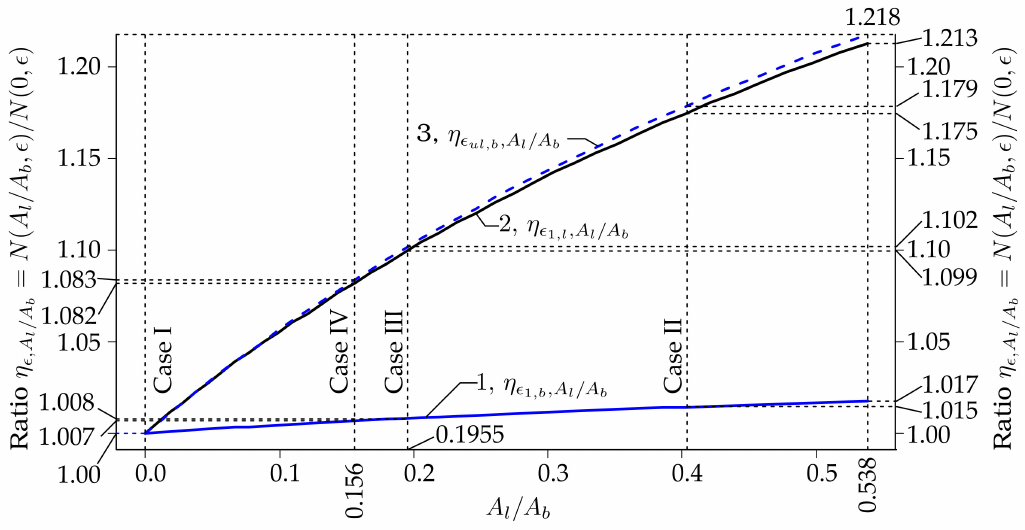
(cid:15) ) / N ( 0, (cid:15) ) , at = N ( A l / A b , l / A b